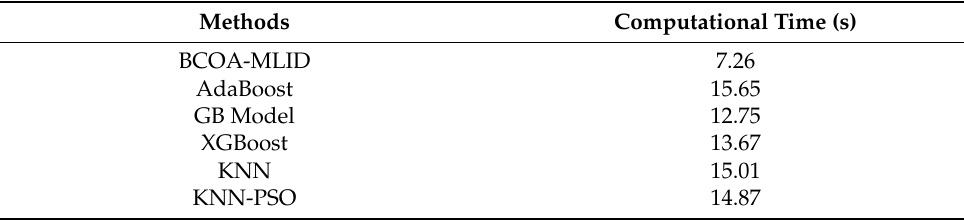
Table 5. CT outcome of the BCOA-MLID approach with recent